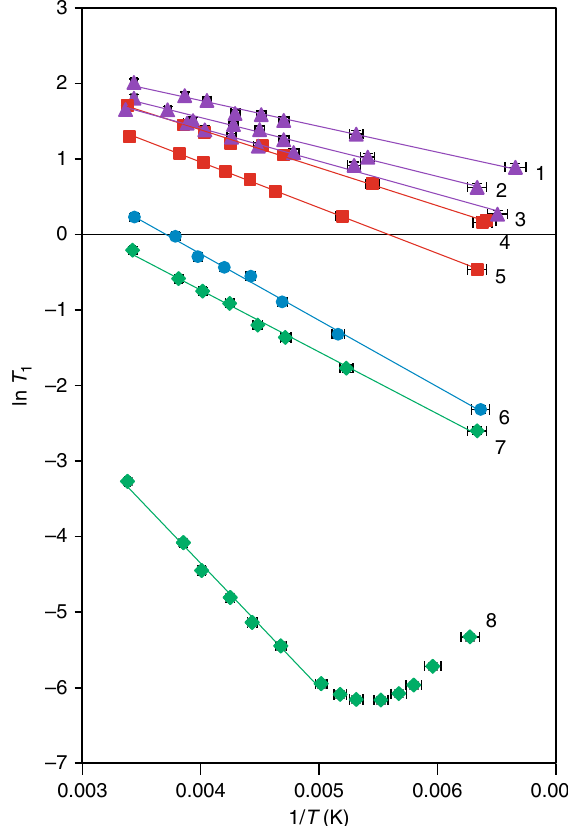
Fig. 3 Experimental ln T 1 relaxation times plotted as a function of the inverse temperature (1/ T ). The error bars represent an upper limit on instability in the temperature and the uncertainty of the T 1 relaxation